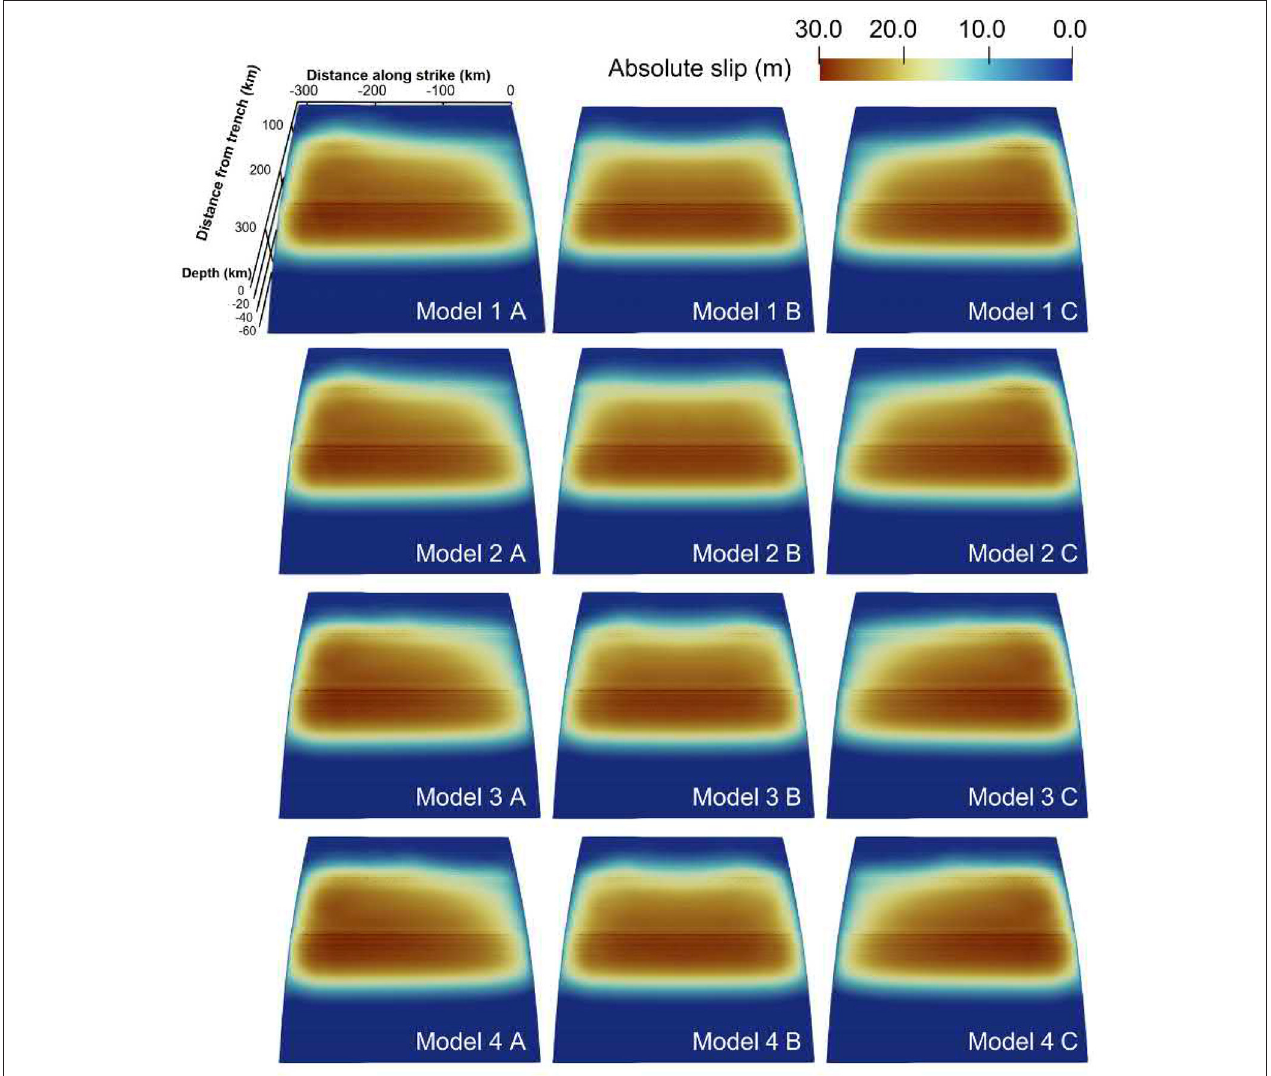
FIGURE 6 | Accumulated fault slip at the end of the simulation, after 200 s for 12 dynamic rupture models. The hypocenter locations vary with depth (25, 30, 40, and 45 km) and laterally on the fault (y = − 78.25 km, y = − 156.5 km, y = − 234.75 km).